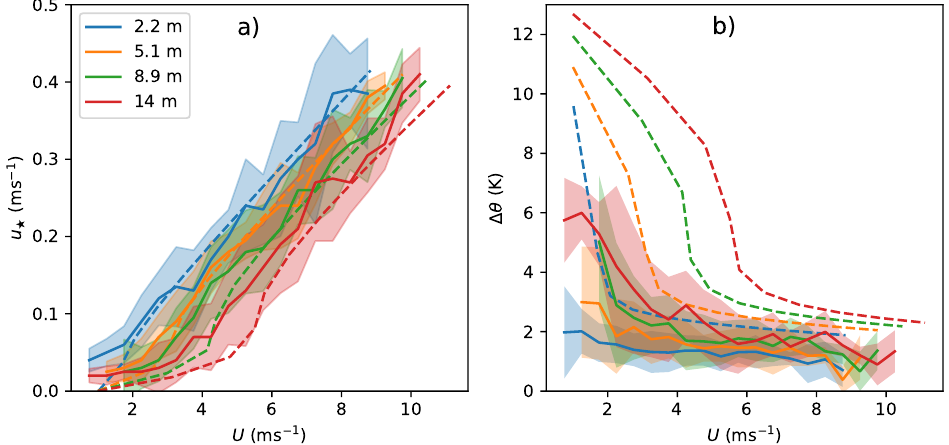
Figure 6. The simulated (dashed curves) and observed (solid curves) u (cid:63) ( a ) and air-surface potential temperature difference ∆ θ ( b ) as functions of U at several